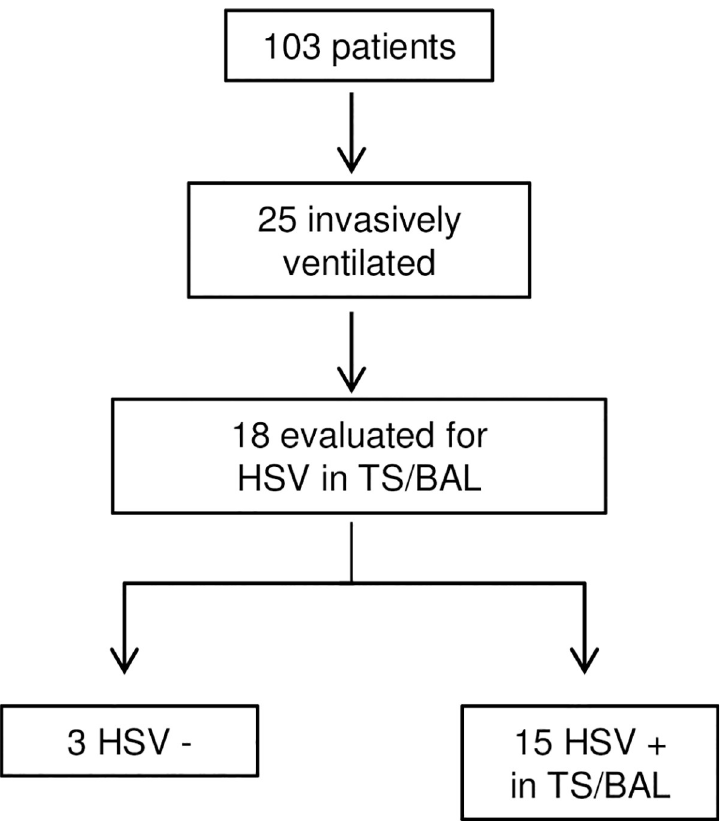
Fig 1. Flow chart of study population and HSV-1 detection in Tracheal Secretion (TS) or bronchial lavages (BAL).